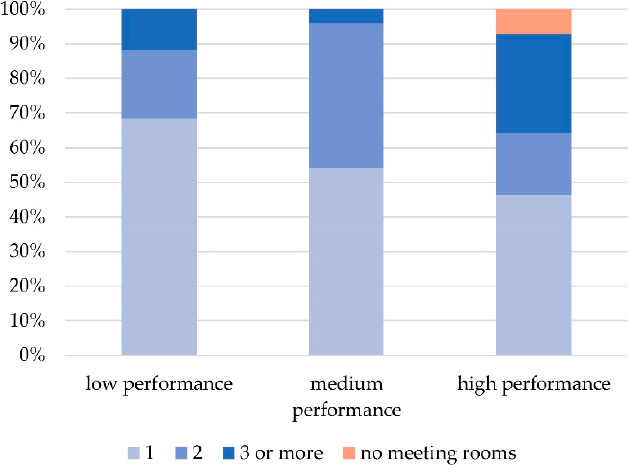
Figure 13. Number of meeting rooms by performance category.